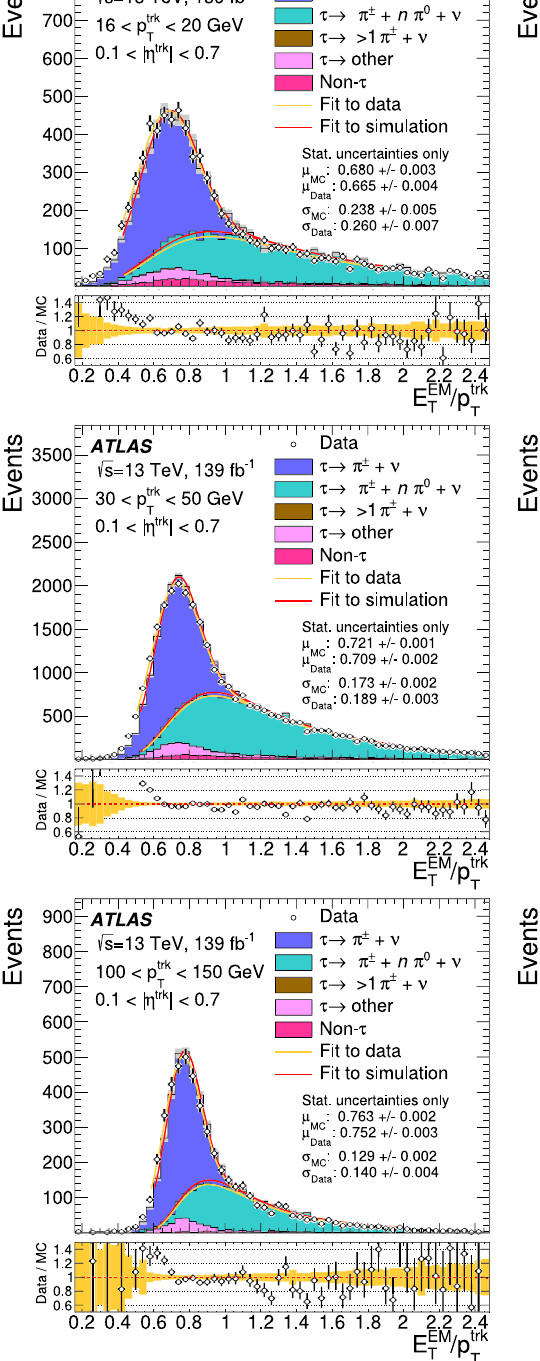
/ p trk Fig. 1 Examples of the E EM of a Gaussian+Landau function and just the Landau component from distribution and fit performed in T T < 20 GeV (top), 30 < p trk < 50 GeV (middle) and this fit are shown. The uncertainties shown are those from the statistics the 16 < p trk T T of the dataset and the limited Monte Carlo sample size. The bottom < 150 GeV (bottom) bins in the barrel (left) and endcaps 100 < p trk T panel shows the ratio of data to simulation with statistical error bars on (right). The data are shown by points with a stacked histogram for simu- the data points and a yellow band illustrating the statistical uncertainty lation. The component where τ -leptons decay to multiple charged pions of the simulation. The simulation is normalised to the integral of the is small and difficult to see. The red fits correspond to simulation and the yellow fits correspond to data. Both the fits to the full distribution